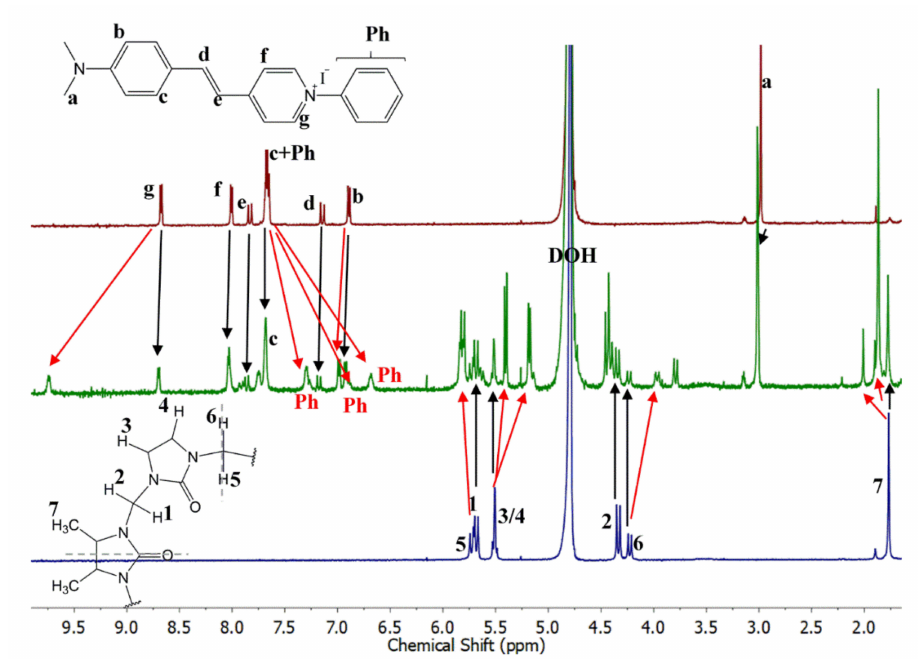
Figure 10. 1 H-NMR spectra (500 MHz, D 2 O) of ( top ) PhSt, ( middle ) PhSt-Me 4 CB6 1:1